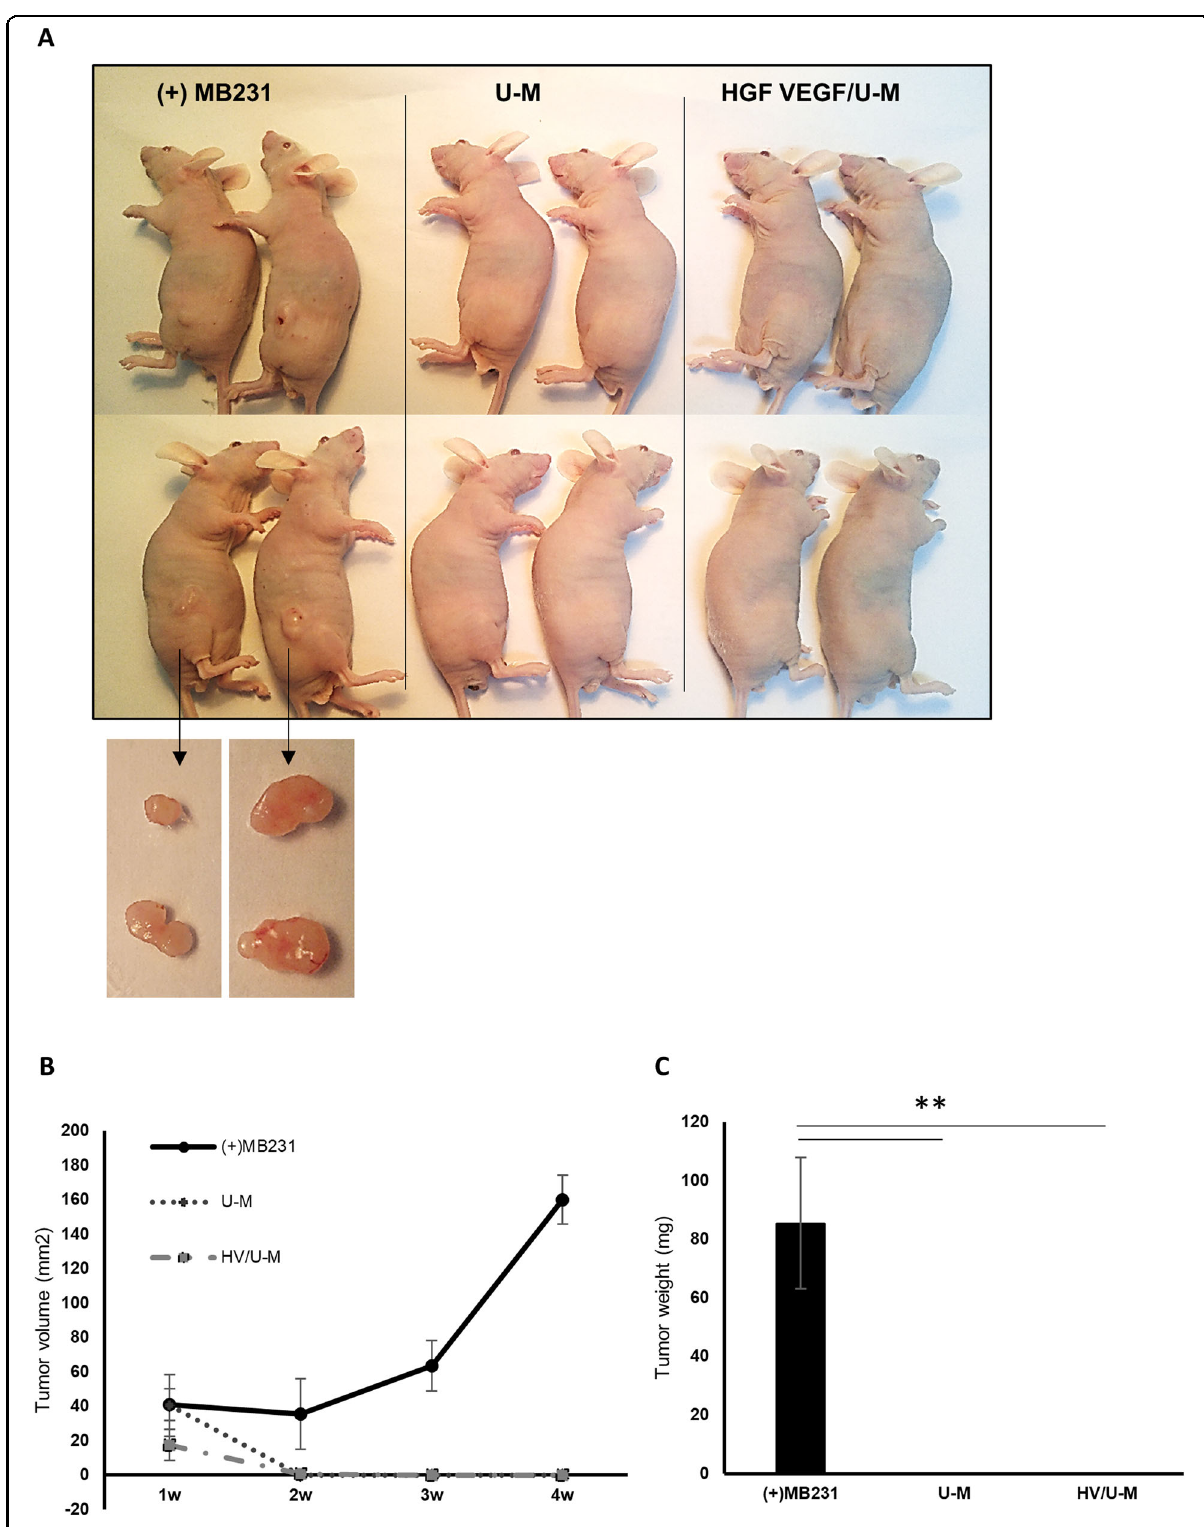
Fig. 7 No tumors were formed in nude mice transplanted with the HGF + VEGF/U-Ms. a Tumor formation was observed 4 weeks after cell transplantation in BALB/c nude mice. MDA-MB-231 cells were used as a positive control. Tumors did not form in the U-M or HGF + VEGF/U-M groups. b The tumor volume was measured weekly. c Mice were sacri fi ced and dissected 4 weeks after transplantation, and tumor formation was analyzed. N =